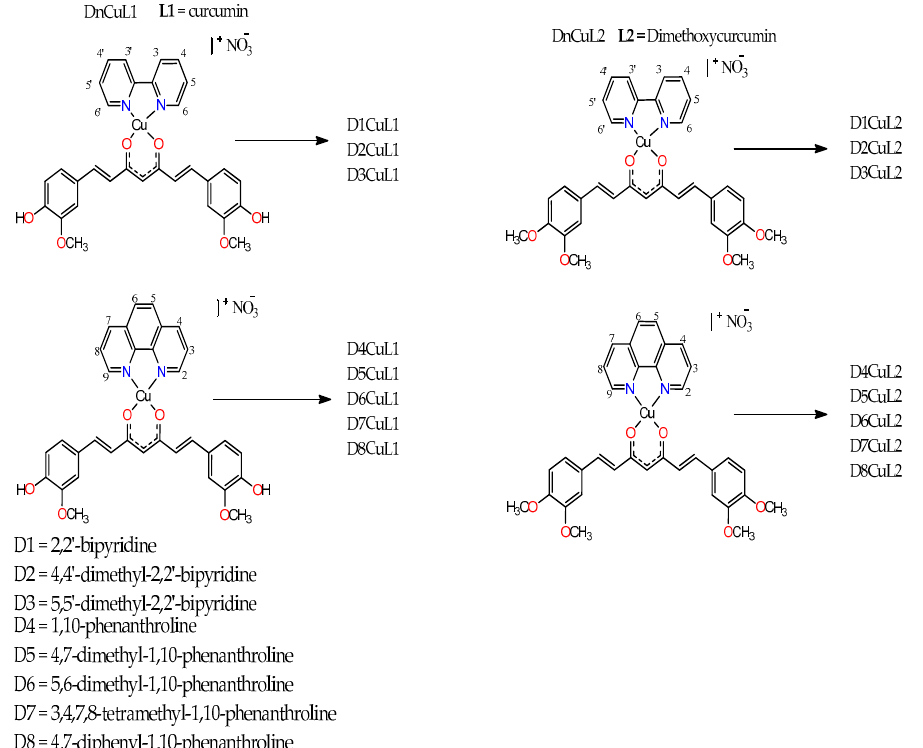
Figure 2. Structure of the studied mixed chelate copper(II) compound.